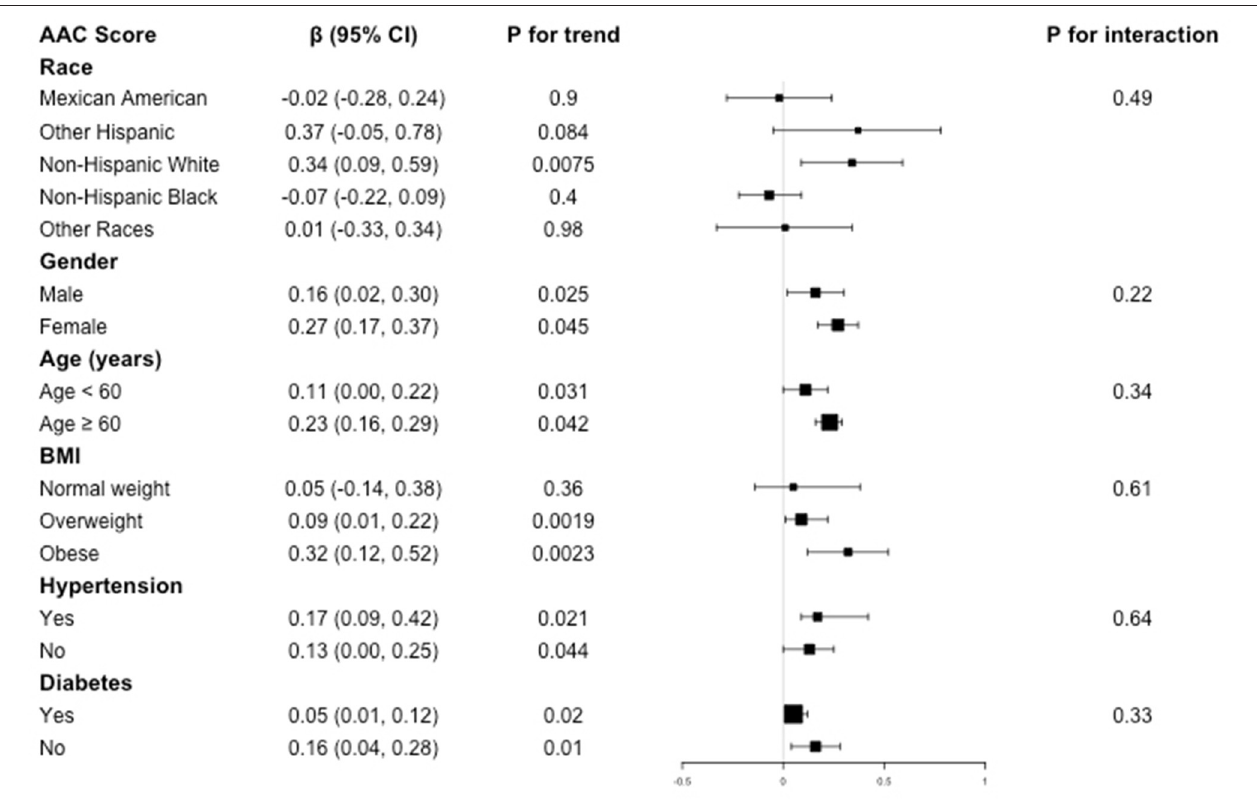
FIGURE 2 | Subgroup analysis for the association between BLL and AAC